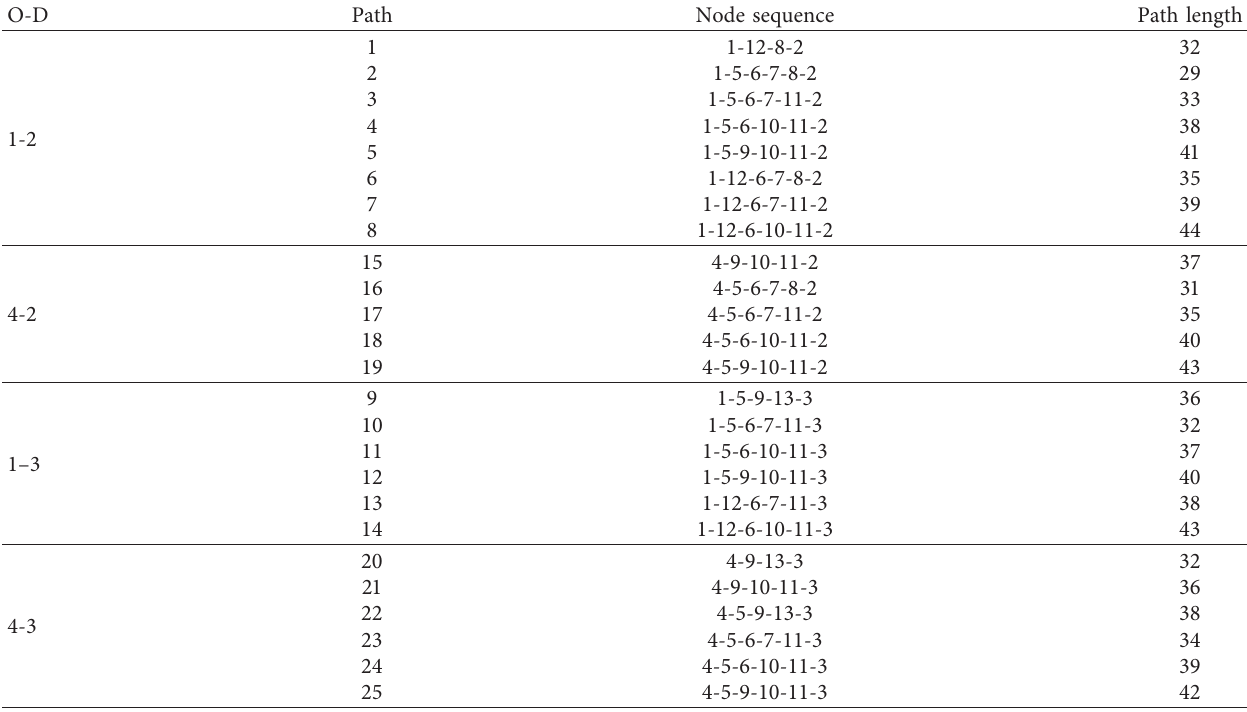
Table 2: Path composition and length.